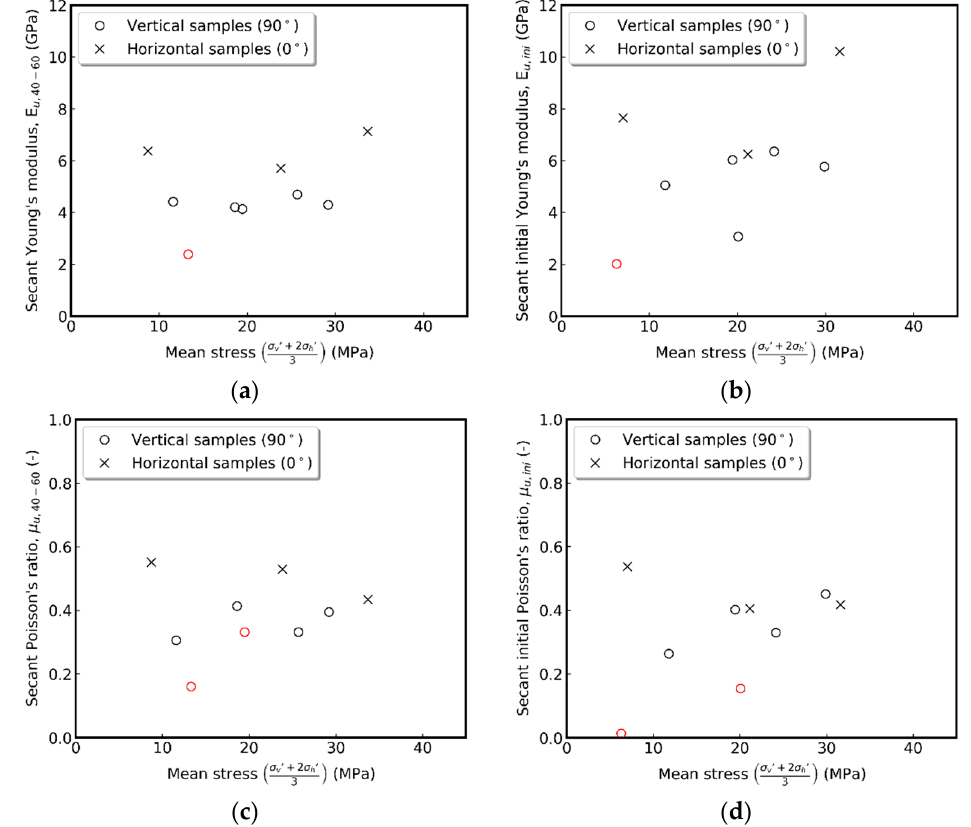
Figure 8. ( a ) Secant-undrained Young’s moduli between 40% and 60% of vertical stress and ( b ) for the initial 0.2% vertical strain during shearing for vertical (o) and horizontal samples (x). ( c ) Secant undrained Poisson’s ratios between 40% and 60% of vertical stress and ( d ) for the initial 0.2% vertical strain during shearing for vertical (o) and horizontal samples (x). Red marker in ( a – d ) for the test with low effective consolidation stress likely influenced by swelling during consolidation and for the test with technical issues with a horizontal deformation sensor in c , d .